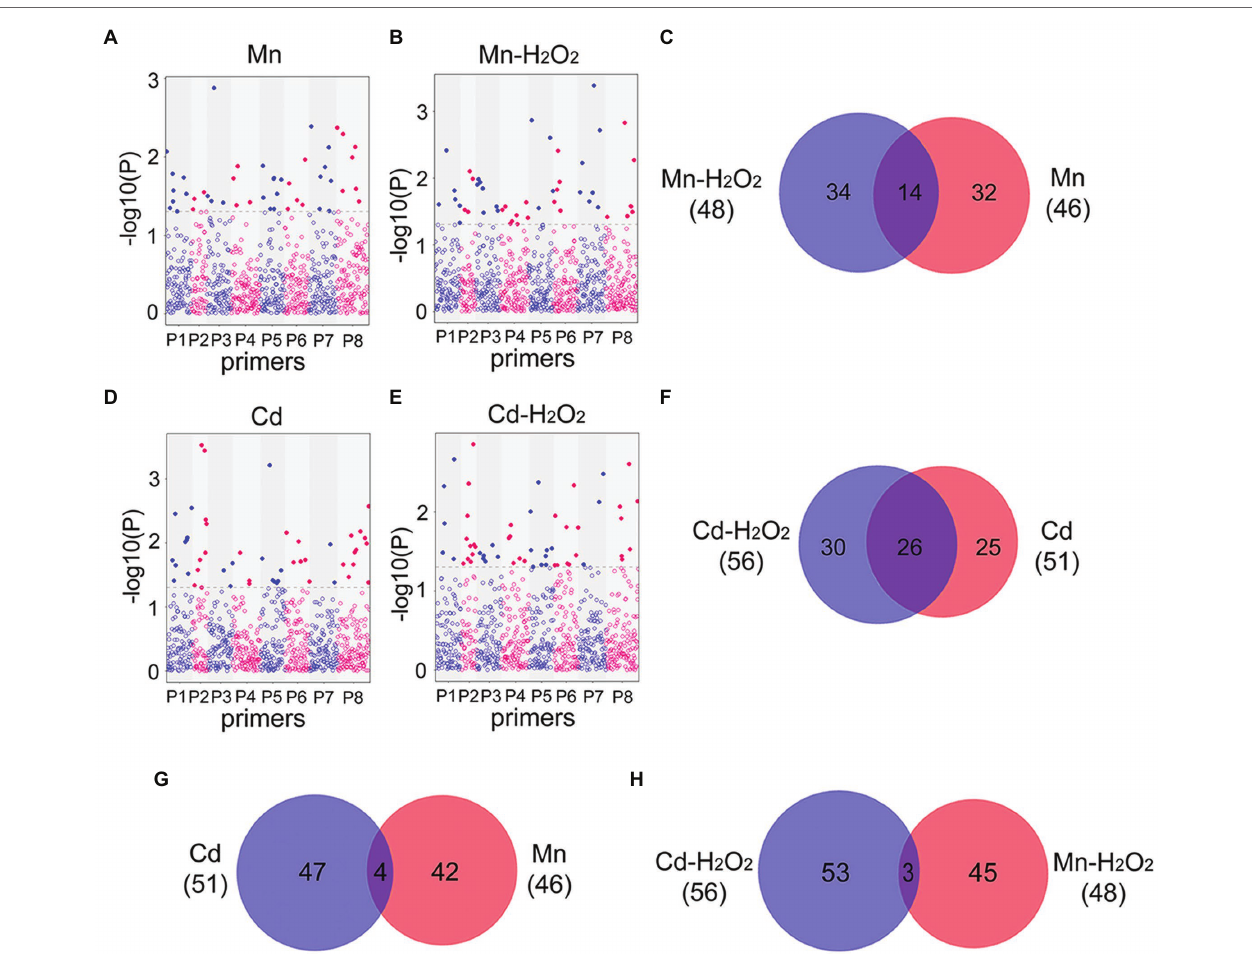
FIGURE 7 | Manhattan plots of total methylated loci significantly associated with (A) leaf Mn content in Mn treatments (Mn); (B) leaf H 2 O 2 content in Mn treatments (Mn-H 2 O 2 ); (D) leaf Cd content in Cd treatments (Cd); and (E) leaf H 2 O 2 content in Cd treatments (Cd-H 2 O 2 ). The x-axis represents different loci amplified in eight MSAP primer pairs ( Supplementary Table S1 ), and the y-axis is − log10 (value of p ). Blue line indicates p < 0.05, and red line indicates p < 0.01. The Venn diagrams show the comparisons of heavy metal associated and H 2 O 2 associated differentially methylated loci (DML, p < 0.05) detected in the four Manhattan plots. (C) Venn diagram of Mn and H 2 O 2 associated DML in Mn treatment; (F) Venn diagram of Cd and H 2 O 2 associated DML in Cd treatment; (G) Venn diagram of Cd and Mn associated DML in Cd and Mn treatments respectively; (H) Venn diagram of H 2 O 2 associated DML in Cd and Mn